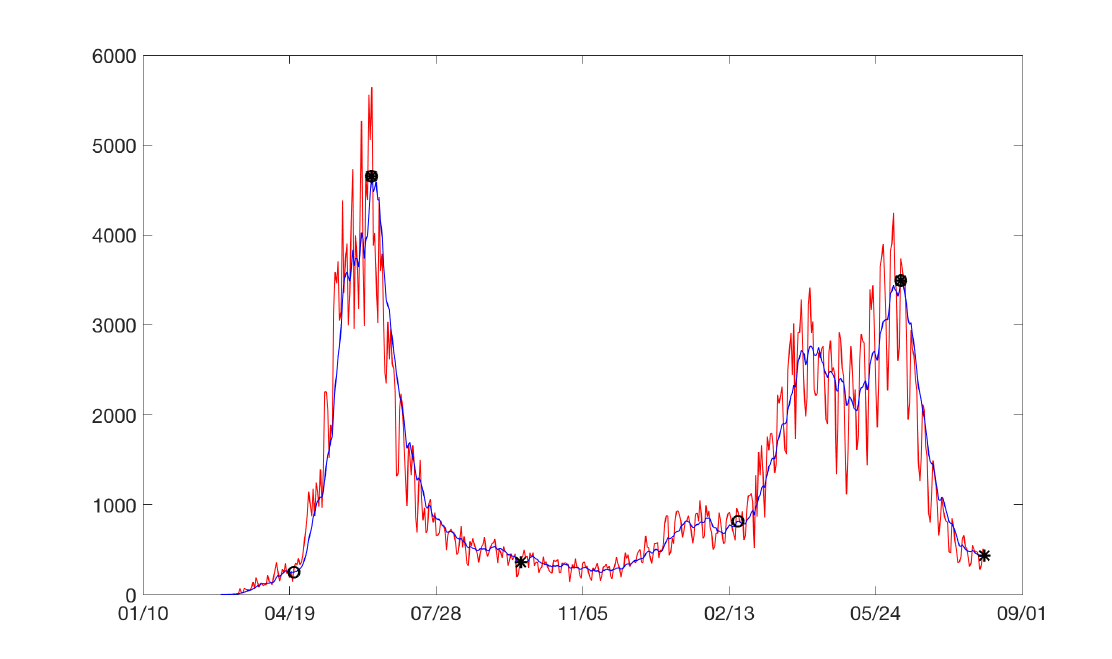
Figure A26. Chile Metropolitan Region: on the horizontal axis is the date in days and on the vertical axis are the daily cases.